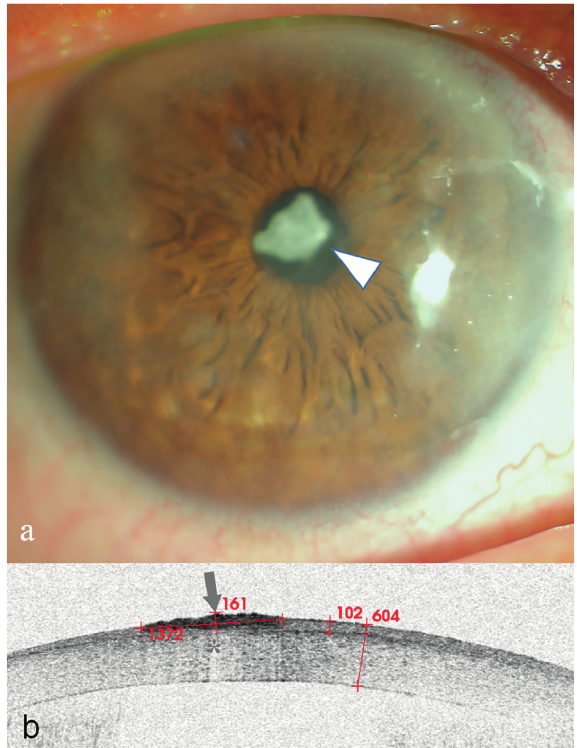
Figure 6: Anterior segment and AS-OCT image for Case 6. (a) Anterior segment photograph showed a slight bulge at 10:00 o’clock in the peripheral cornea (white arrowhead). Corneal fluorescein staining was negative (arrowhead). (b) AS-OCT scanning showed there was a lesion of high signal with blurred boundary (arrow) without a shadowing effect. The lesion was di- rectly located and was 136 μ m beneath the corneal